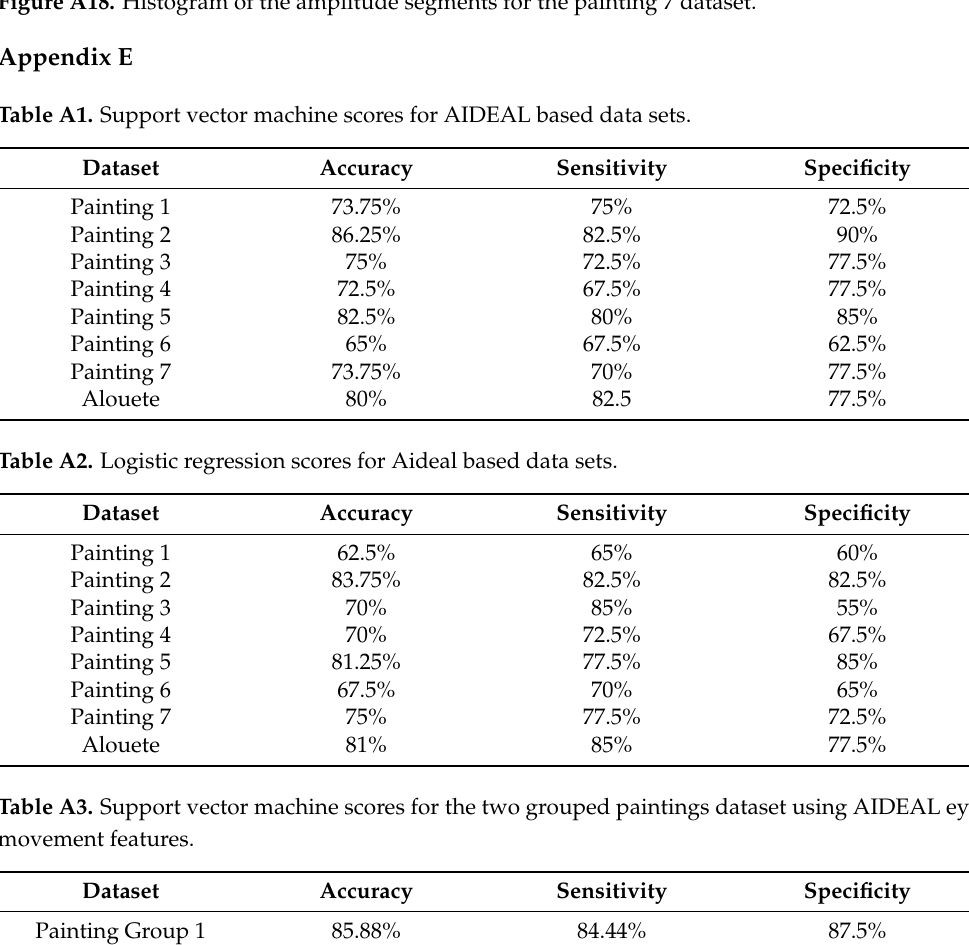
Table A4. Logistic regression scores for the two grouped paintings dataset using AIDEAL eye